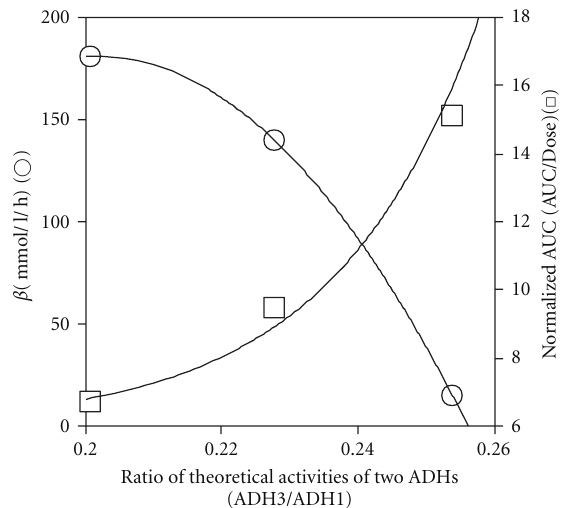
Figure 8: E ff ect of ethanol dose on theoretical liver ADH 1 and ADH 3 activities in two-ADH-complex model. Liver ADH 1 activity was estimated by multiplying the ADH 1 content by the V max /mg of ADH 1 (4.0units/mg). The ADH 3 activity was calculated by subtracting the ADH 1 activity from the total liver ADH activity. The total liver ADH activity was from Figure 3(a) and liver ADH 1 content from Figure 3(b). The theoretical ADH 1 ( (cid:2) ) and ADH 3 ( (cid:2) ) activities were obtained by normalizing by the ratio of the total ADH activity to that for the control.